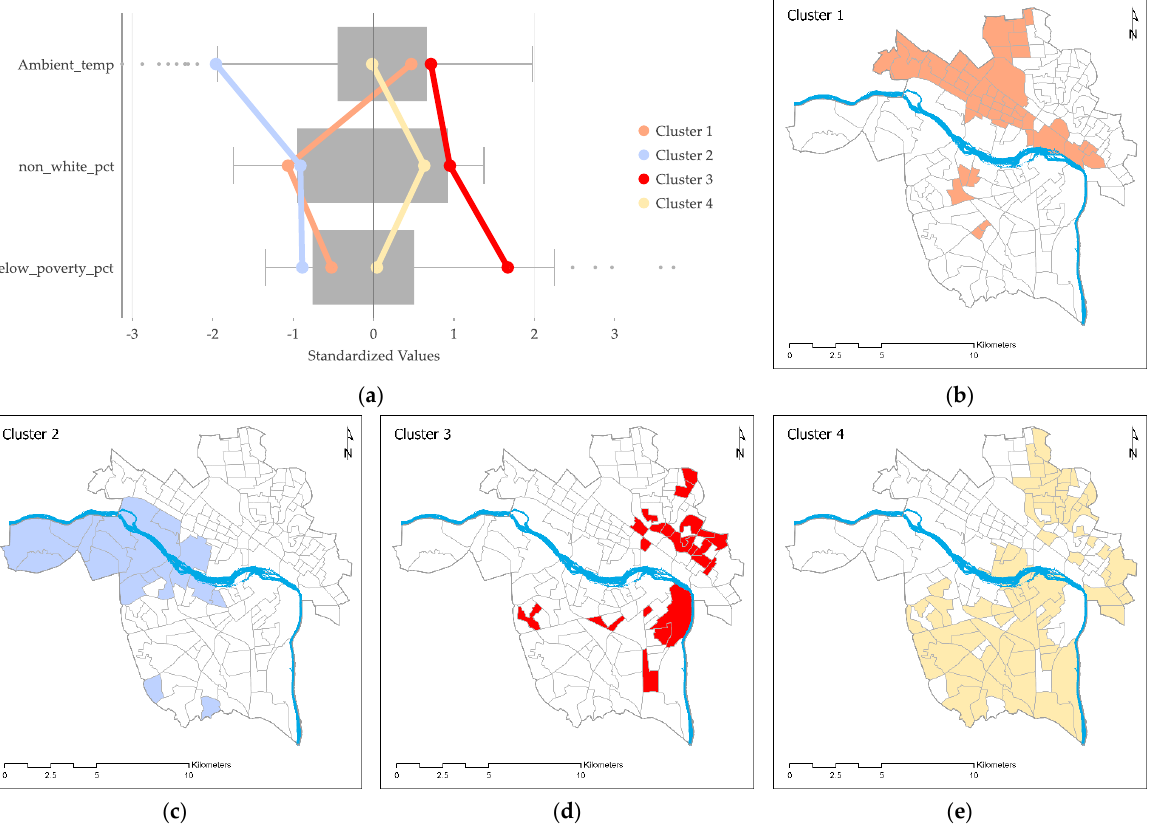
Figure 5. Multivariate clustering analysis of ambient temperature ( Ambient_temp ), percentage of non-white population ( non_whte_pct ), and percentage of population with income below poverty level ( below_poverty_pct ): ( a ) box-plots; ( b ) Cluster 1; ( c ) Cluster 2; ( d ) Cluster 3; ( e ) Cluster 4.